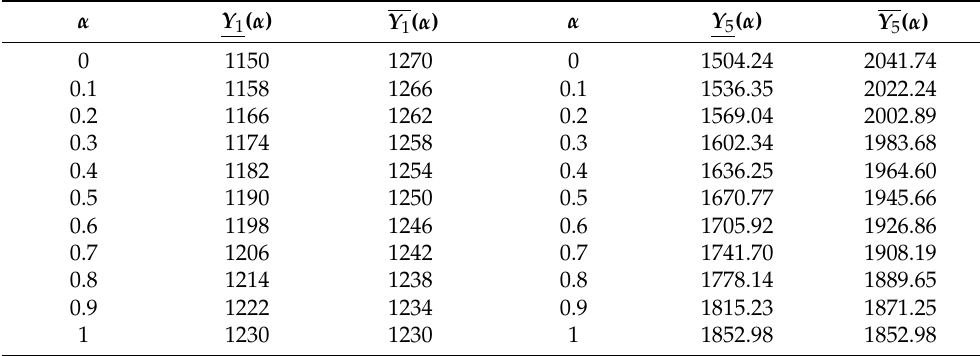
Table 2. α -cuts of income in the periods t = 1 and t = 5.